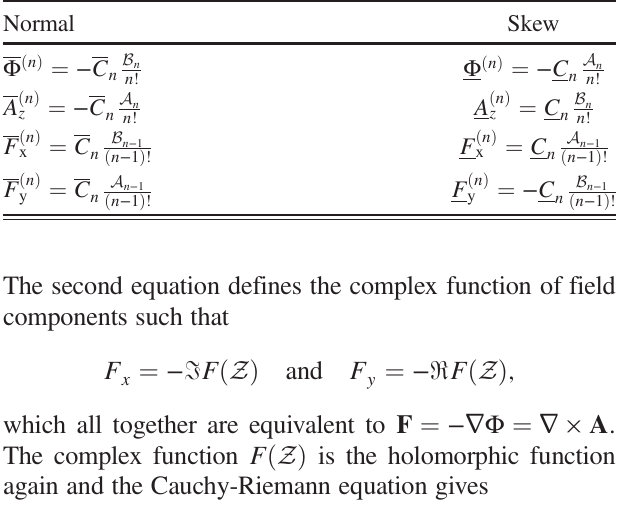
TABLE I. Formulas for the scalar potential, longitudinal component of the vector potential and field components for pure normal and skew 2 n -poles in Cartesian coordinates. Normal Skew